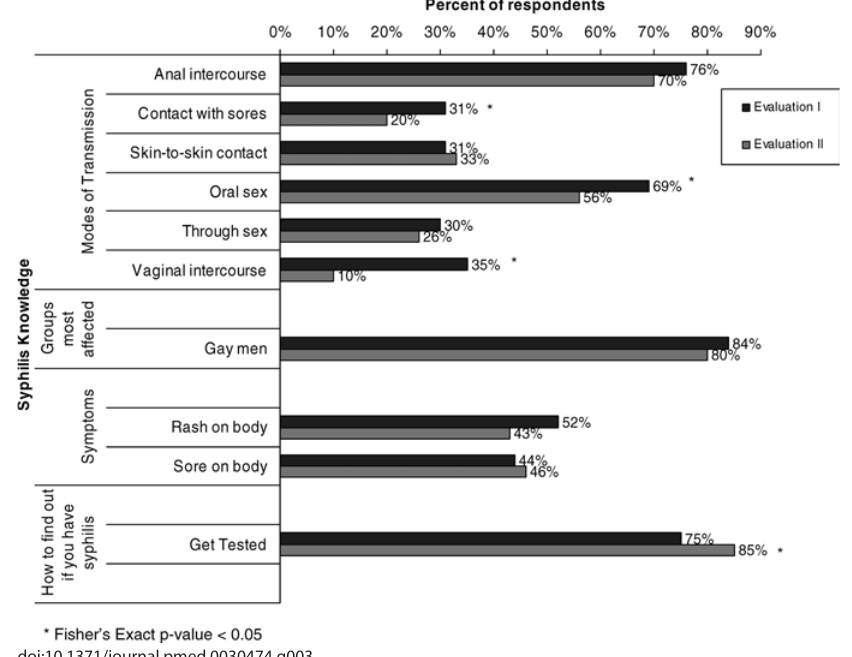
Figure 3. Syphilis Knowledge among Respondents Aware of the Healthy Penis Campaign, by Evaluation